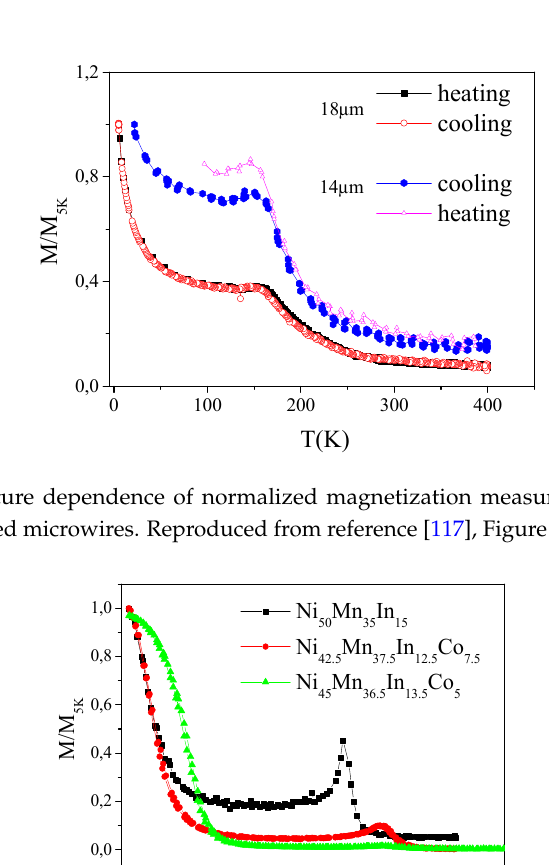
T ann =773K Figure 42. Temperature dependence of magnetization for NiMnGa microwires (d = 18 μ m) annealed at 773 K with different conditions. Reproduced from reference [117], Figure 4. Similar tendency (appreciable increasing of T c ) has been observed for Ni 50 Mn 35 In 15 and Ni 42.5 Mn 37.5 In 12.5 Co 7.5 samples (Figure 43). 0